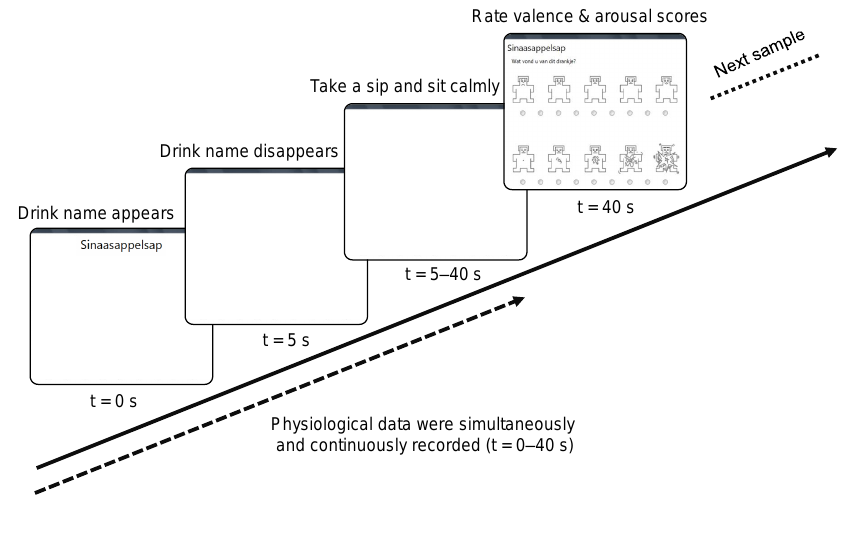
Figure 1. Schematic overview of an experimental trial. Participants clicked the small circles below the SAM scales in order to give their response, after which, a new trial